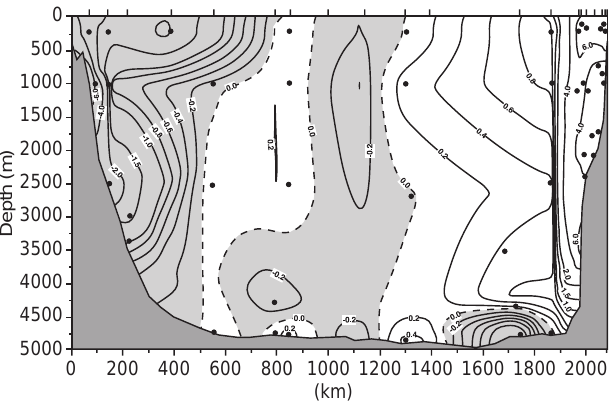
Fig. 3. Cross-section velocity interpolated by Fahrbach et al. (1994b) on the basis of the long-term moored measurements performed in the Weddell Sea. Contour interval is 0.2 cm/sec. Shaded areas denote outflows. Instrument locations are shown by solid